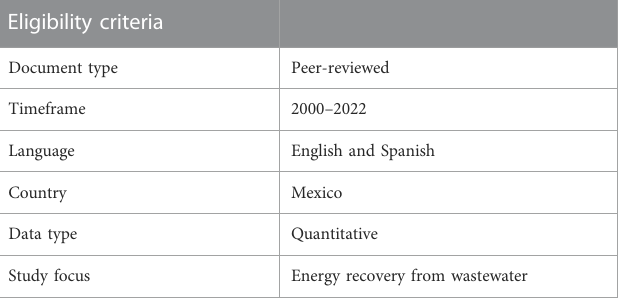
TABLE 1 Eligibility criteria for studies to be included in this